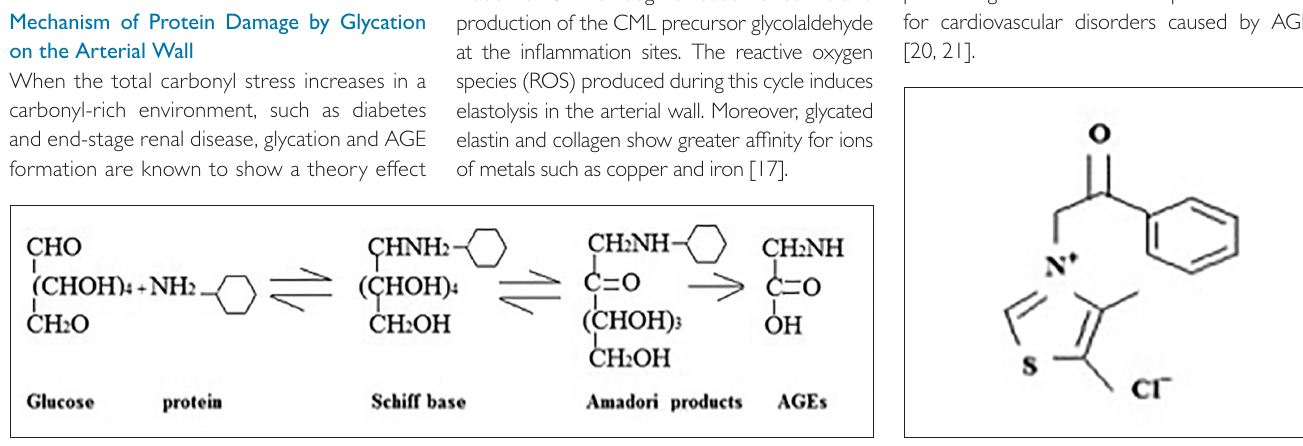
Figure 1. AGE formation. Figure 2. Alagebrium chemical